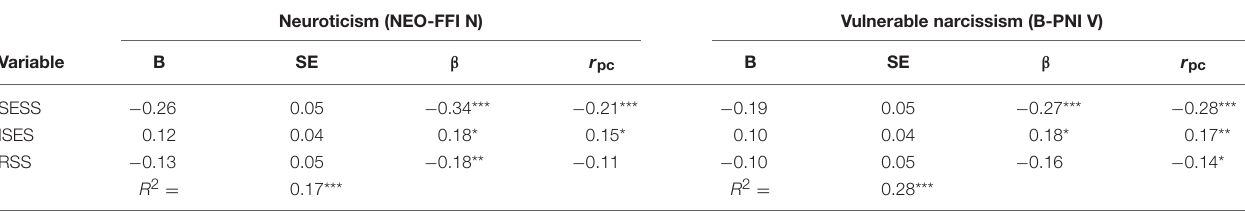
TABLE 3 | Multiple regression analyses in predicting neuroticism and vulnerable narcissism. Neuroticism (NEO-FFI N)